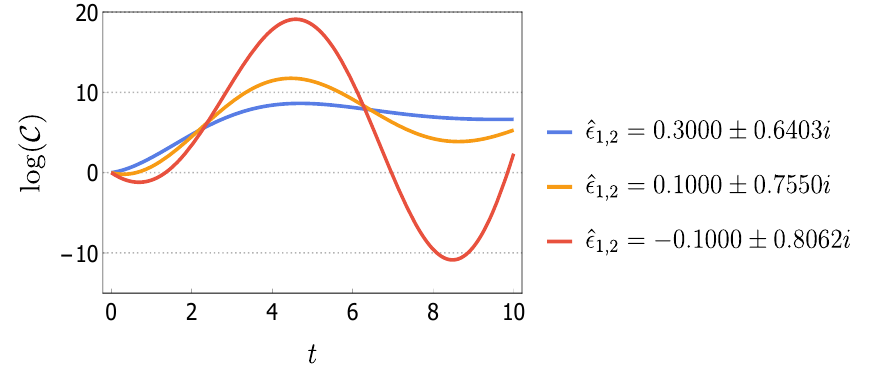
Figure 7 . Evolution of Complexity for a K = 2 parameter system with a variation of eigenvalue of Encoder-Dataset tensor A ∞ in a non-chaotic regime. The non-zero complex part of the eigenvalues of A ∞ gives rise to the oscillatory behavior of the Complexity.